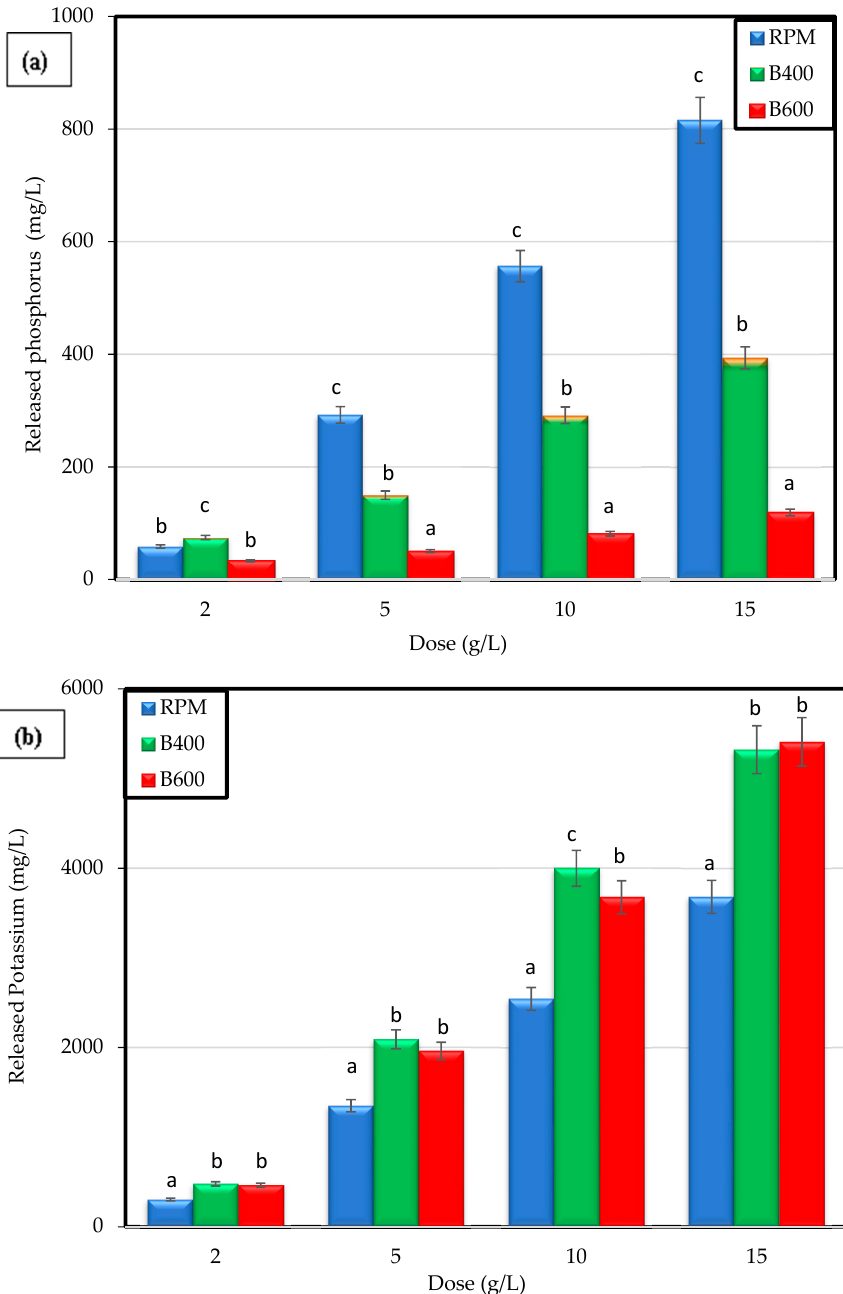
Figure 5. E ff ect of the used solid matrix doses on the release e ffi ciency of phosphorus ( a ) and potassium Figure 5. Effect of the used solid matrix doses on the release efficiency of phosphorus ( a ) and ( b ) (pH = 6.2, T = 20 ± 2 ◦ C). At each dose, means with the same lowercase letters are not statistically potassium ( b ) (pH = 6.2, T = 20 ± 2 °C). At each dose, means with the same lowercase letters are not di ff erent at p < statistically different at p < 0.05.